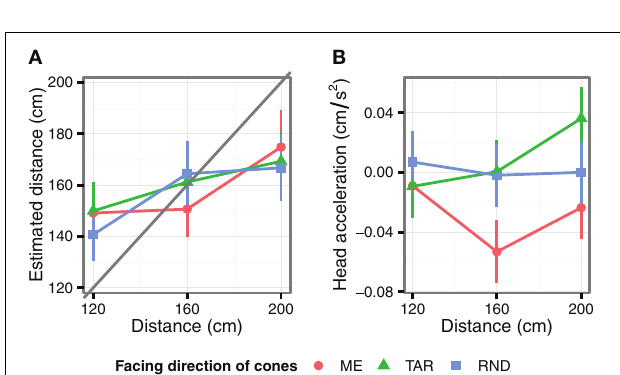
visual image of the ME (all cones are facing the observer), TAR (all cones are facing an invisible target located behind the cones), and RND (the cone orientations are random) conditions.